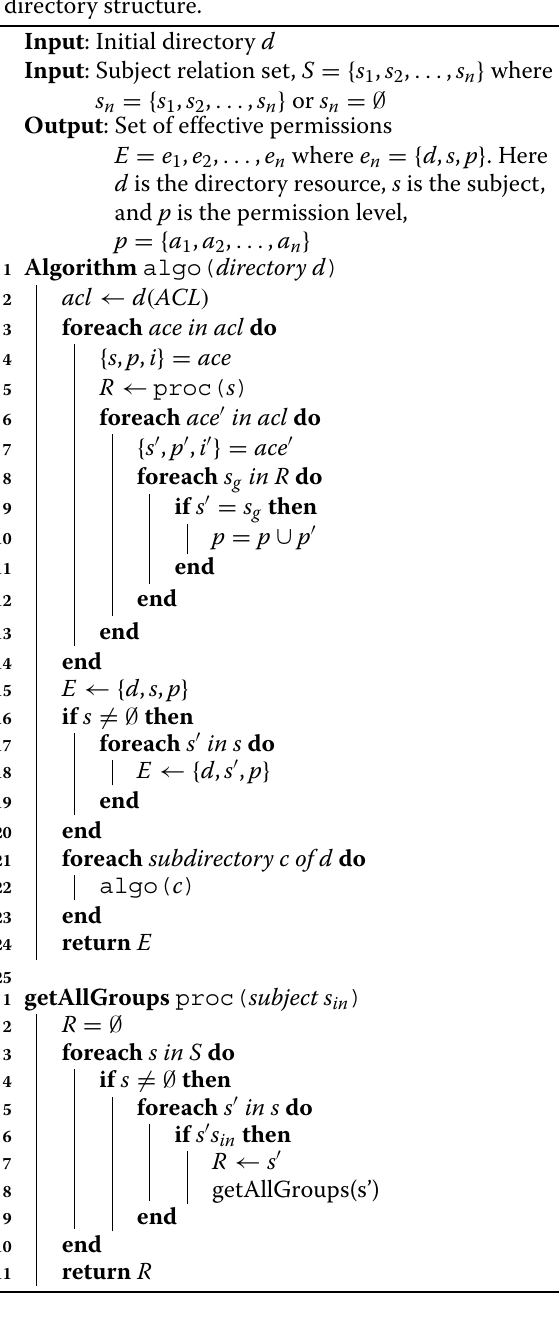
Algorithm 1 details the process of how the effec-